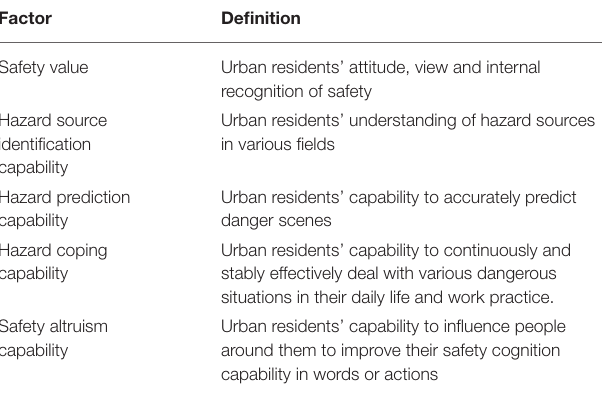
TABLE 6 | Definition of each